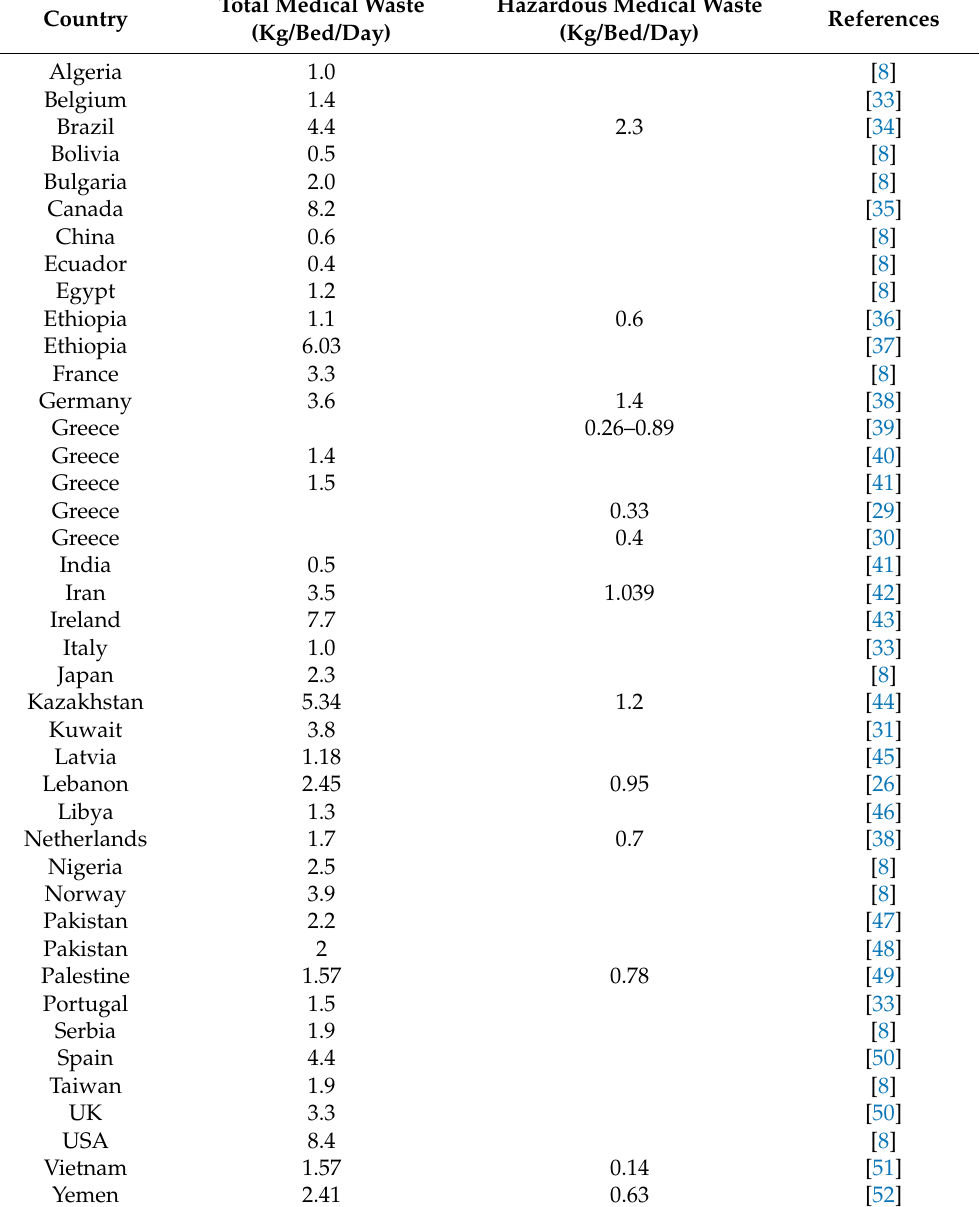
Table 1. Medical waste generation